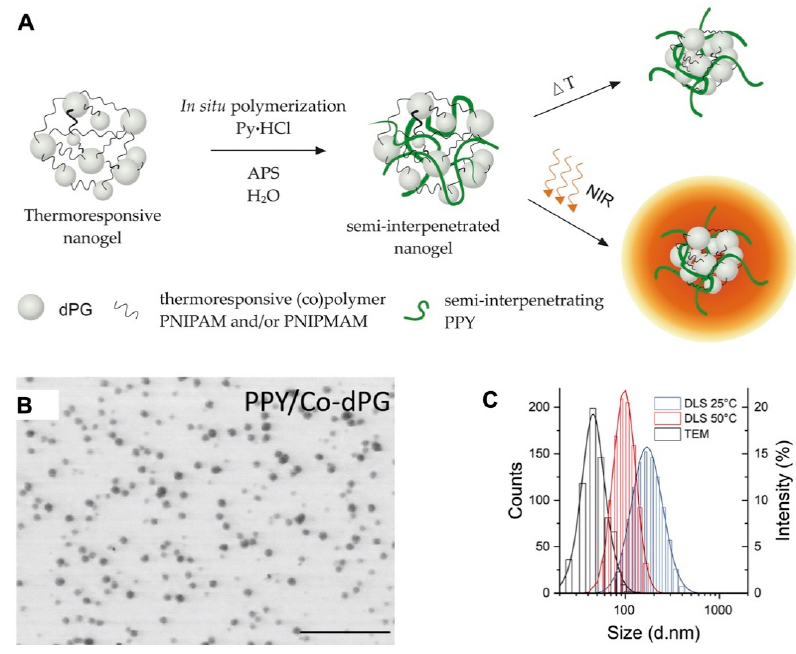
Figure 1. ( A ) The scheme for synthesis of dual responsive nanogels via semi-interpenetration method. The N-isopropylacrylamide (NIPAm)-based polymer network and interpenetrated polypyrrole (PPY) enabled the nanogels with thermoresponsive property and near-infrared (NIR)-induced photothermal convention, respectively; (Pyrrole ∙ HCl (Py ∙ HCI) as the base and ammonium persulfate (APS) as an initiator were introduced for polymerization); the TEM images ( B ) and hydrodynamic size distribution ( C ) of PPY/Co-dPG nanogels. Adapted from (Journal of Controlled Release. 2019, 311–312,